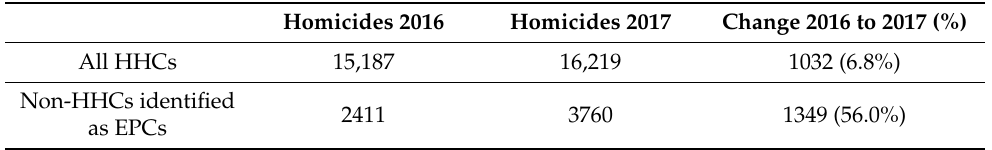
Table 4. Increase in homicides in high homicide cities in Brazil and the increase in homicides in emerging problematic cities that were not